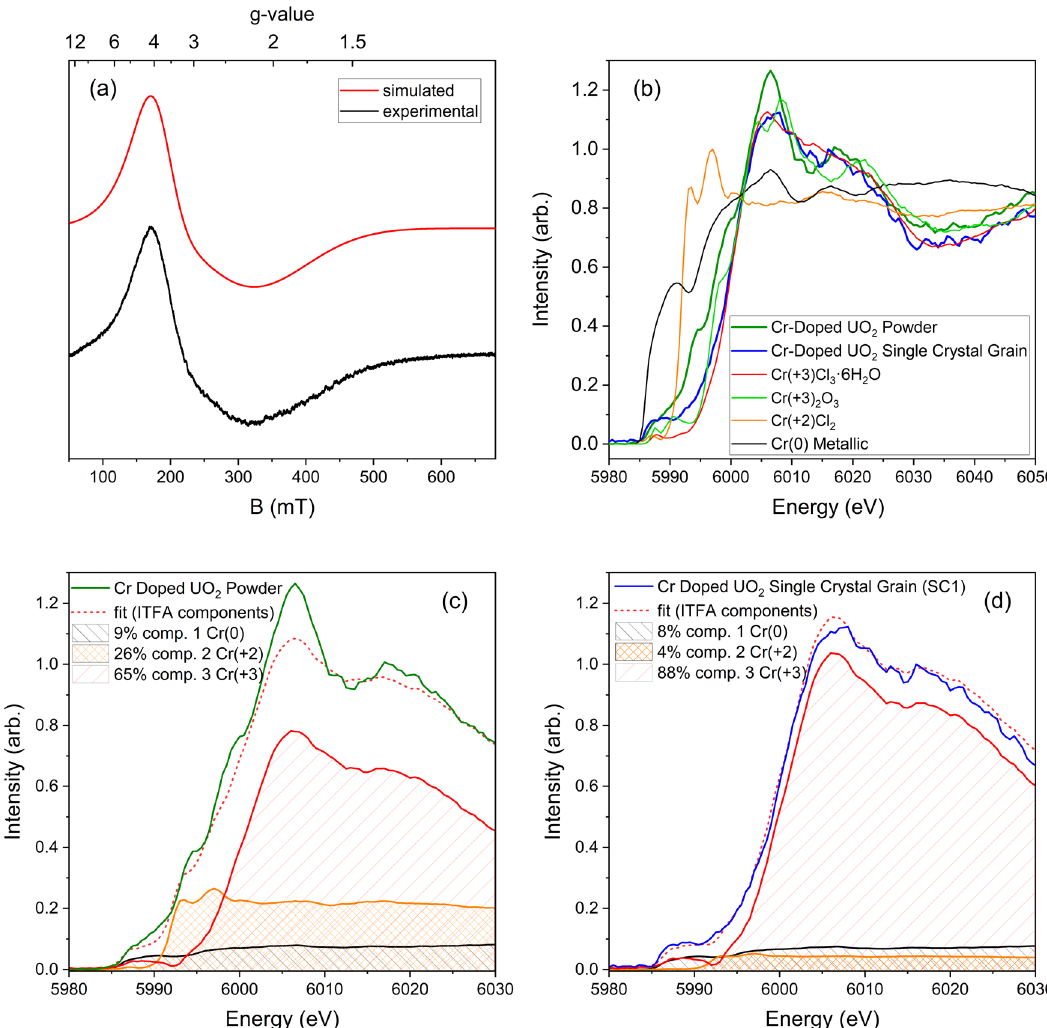
Fig. 2 | EPR and HERFD-XANES spectroscopic analysis of Cr-doped UO 2 single crystals and bulk material. a Measured and modelled EPR spectra of Cr-doped UO 2 single crystal grains at room temperature. b Normalised Cr K-edge HERFD- XANESspectrainthe range5980 – 6050eV forCr-doped UO 2 aspowder and single crystal grain, Cr 0 (metallic), Cr +2 Cl 2 , Cr +3 Cl 3 ·6H 2 O, and Cr +3 2 O 3 . c Normalised Cr K-edge HERFD-XANES spectra in the range 5980 – 6030eV for Cr-doped UO 2 bulk